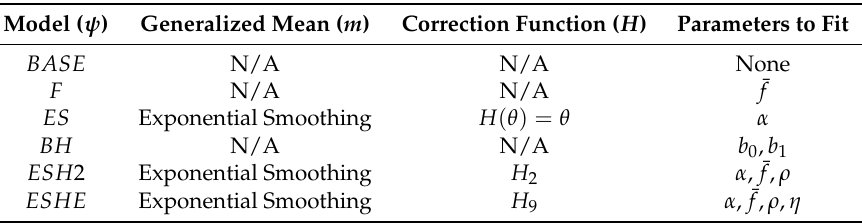
Table 4. Details of the models fit to the data.